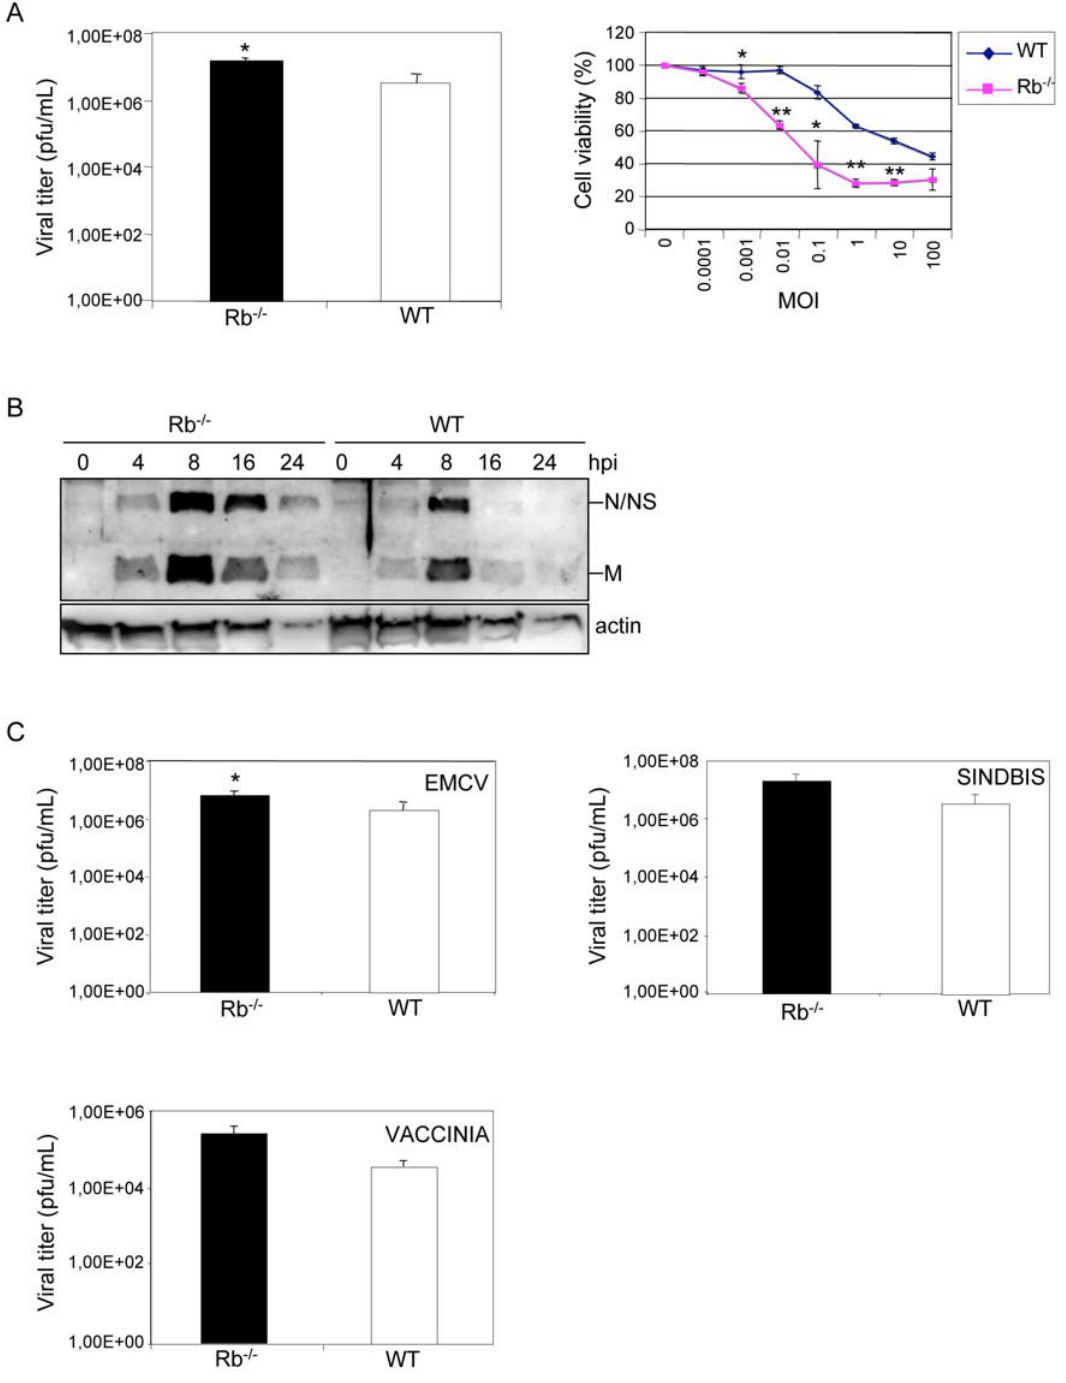
Figure 1. Rb 2 / 2 MEFs are more susceptible to virus infection. A, Rb 2 / 2 or WT MEFs were infected in duplicate with VSV at M.O.I. of 5 and a quantification of the virus yield after a total destruction of the monolayers was assessed (left panel). The same results were obtained in at least three different experiments and using MEFs derived from three different wild type or transgenic embryos. Data represent means + / 2 SE for one experiment. *, P , 0.05, compared with WT cells, Student’s test. Right panel, Rb 2 / 2 or WT MEFs were infected with VSV at the indicated M.O.I. and 24 h after infection, cell viability was quantified as described in Methods. Indicated values are means + / 2 SE of triplicate wells for one experiment. The same results were obtained in at least three different experiments and using MEFs derived from three different wild type or transgenic embryos. *, P , 0.05, **, P , 0.005, compared with WT cells, Student’s test. B, Rb 2 / 2 or WT MEFs were infected with VSV at a M.O.I. of 0.5 and at the indicated times, Western-blotting analysis using antibodies against VSV proteins was performed. C, Rb 2 / 2 or WT MEFs were infected with EMCV, sindbis virus or vaccinia virus at M.O.I. of 5 and when the viability of all the cells was lost quantification of the intracellular virus yield (vaccinia virus) or the virus present in the supernatant (EMCV or sindbis virus) was measured. Data represents means + / 2 SE for four experiments. *, P , 0.05 compared with WT cells, Student’s test.